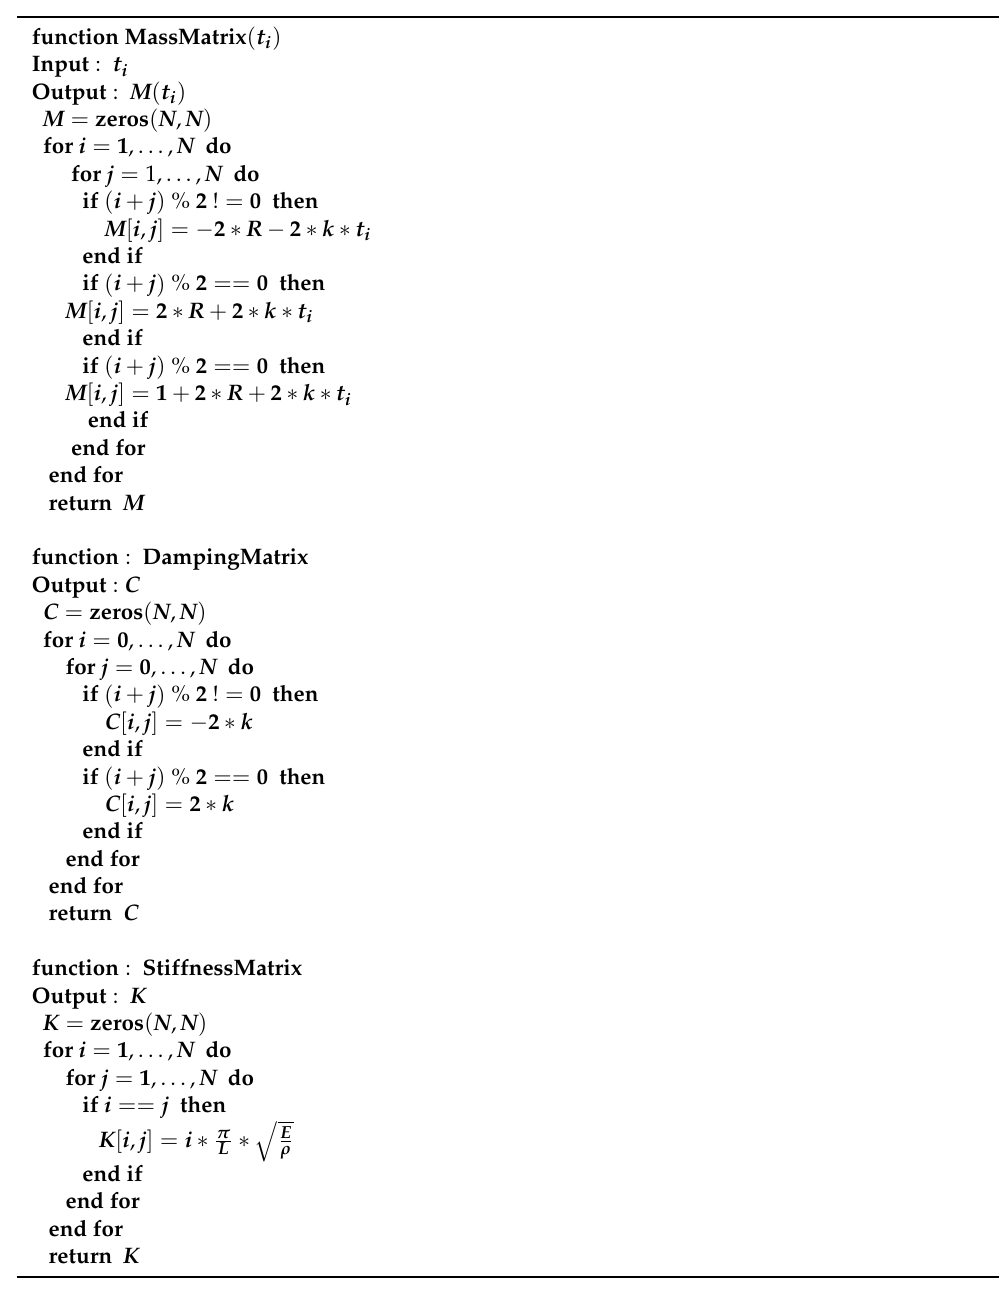
Table 2. Formation of system matrices [ M ( t i )] , [ C ] , [ K ] , [ D ( t i )]